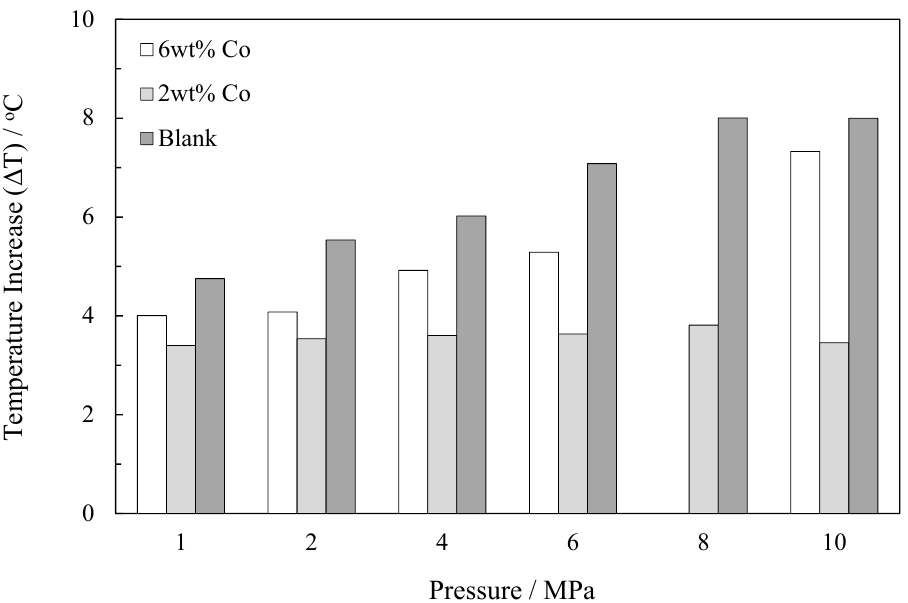
Figure 4. The temperature increase ( Δ T) as a function of operating pressure for plasma-catalytic FTS (NTP + Blank, 2 or 6 wt% Co catalyst) at a discharge time of 60 s (N.B. the discharge time for the 6 wt% Co catalyst at 10 MPa was ~12 s). Legend: □ —6 wt% Co; ■ —2 wt% Co; ■ —Blank. Operating conditions: Syngas (H2/CO) ratio: 2.2:1; current: 350 mA; inter-electrode gap: 1 mm; wall temperature: 25 °C.